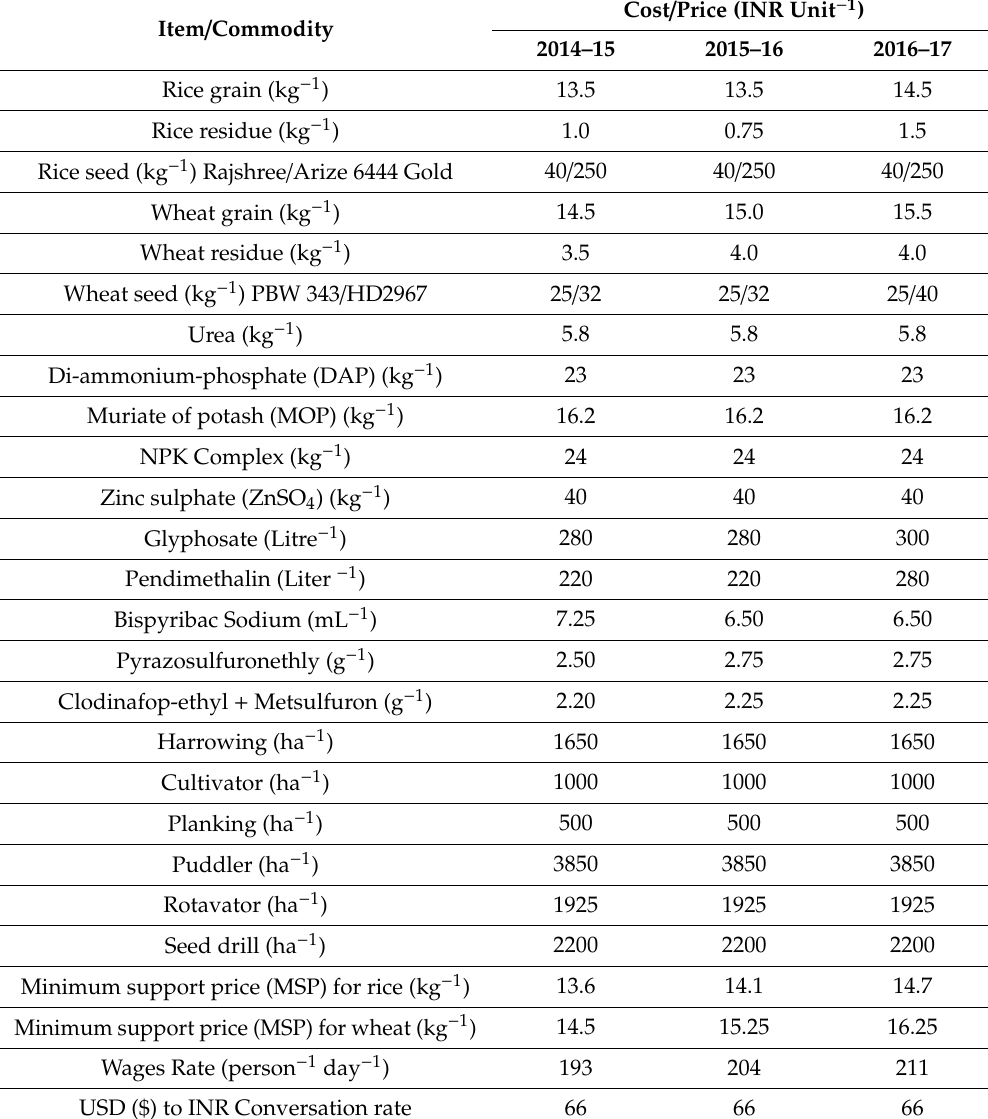
Table 4. Cost / price of key inputs and outputs used for economic analysis during the di ff erent